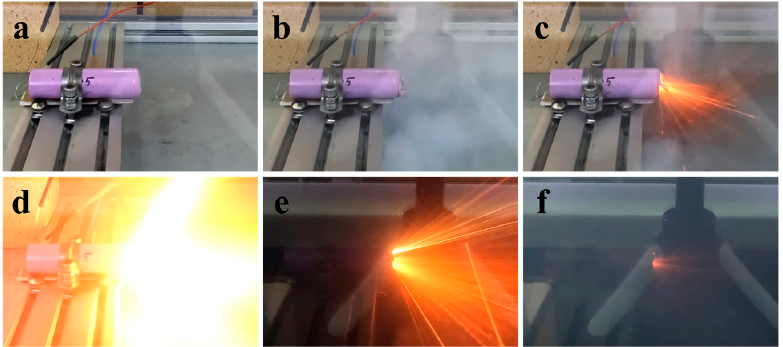
Figure 4. Sequential processes of thermal runaway for a NCA lithium-ion battery at T p = 250 ◦ C; ( a ) 1st vent, ( b ) electrolyte vent, ( c ) spark plasma, ( d ) maximum temperature, ( e ) lull state, and ( f ) end of TR.